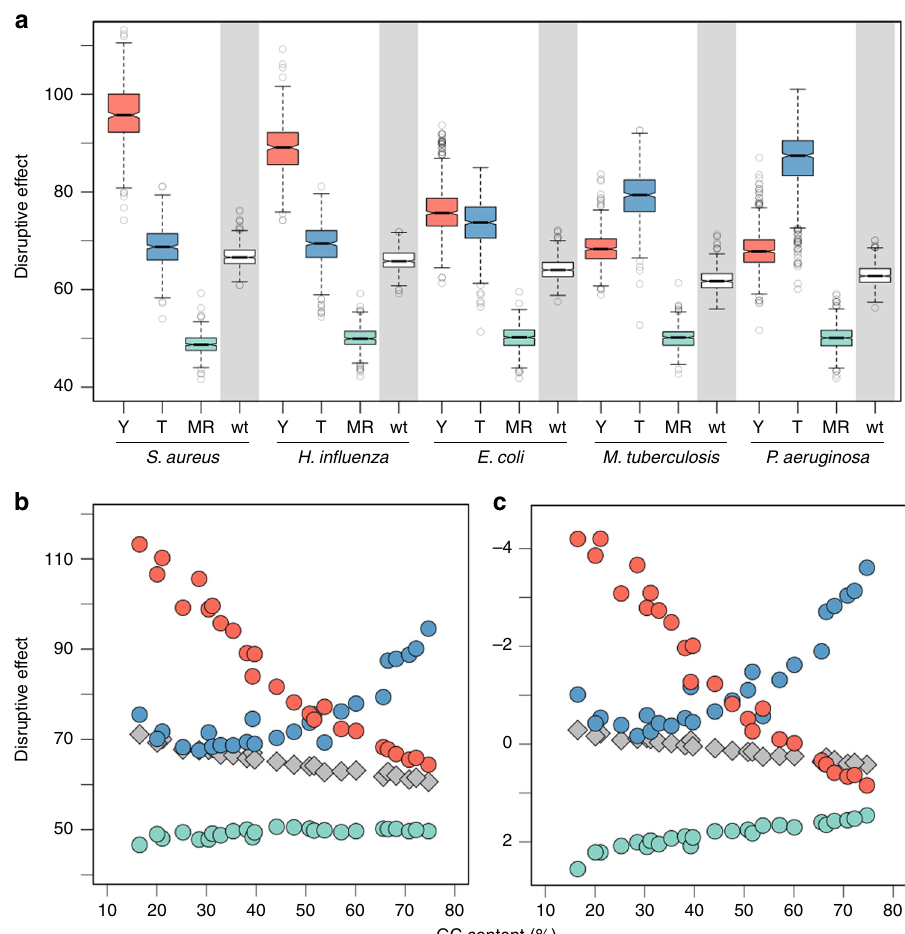
Fig. 4 Protein-disrupting effects of mutations caused by different mutators in different genomes. Colours correspond to predictions for mutY – (red), mutT – (blue) and Mismatch Repair – (green) mutators. For comparison, the effects of a unbiased spectrum are highlighted with a grey background. a Grantham scores in fi ve different bacterial species for which hypermutability is of particular interest. These species are arranged, from left to right, according to increasing GC content. b Average Grantham scores across a panel of species with genomes spanning a wide range of GC compositions. Boxplots as de fi ned by default. c Average BLOSUM100 scores across the same panel. Details about these genomes are shown in Supplementary Table 1. Source data are provided as a Source Data fi